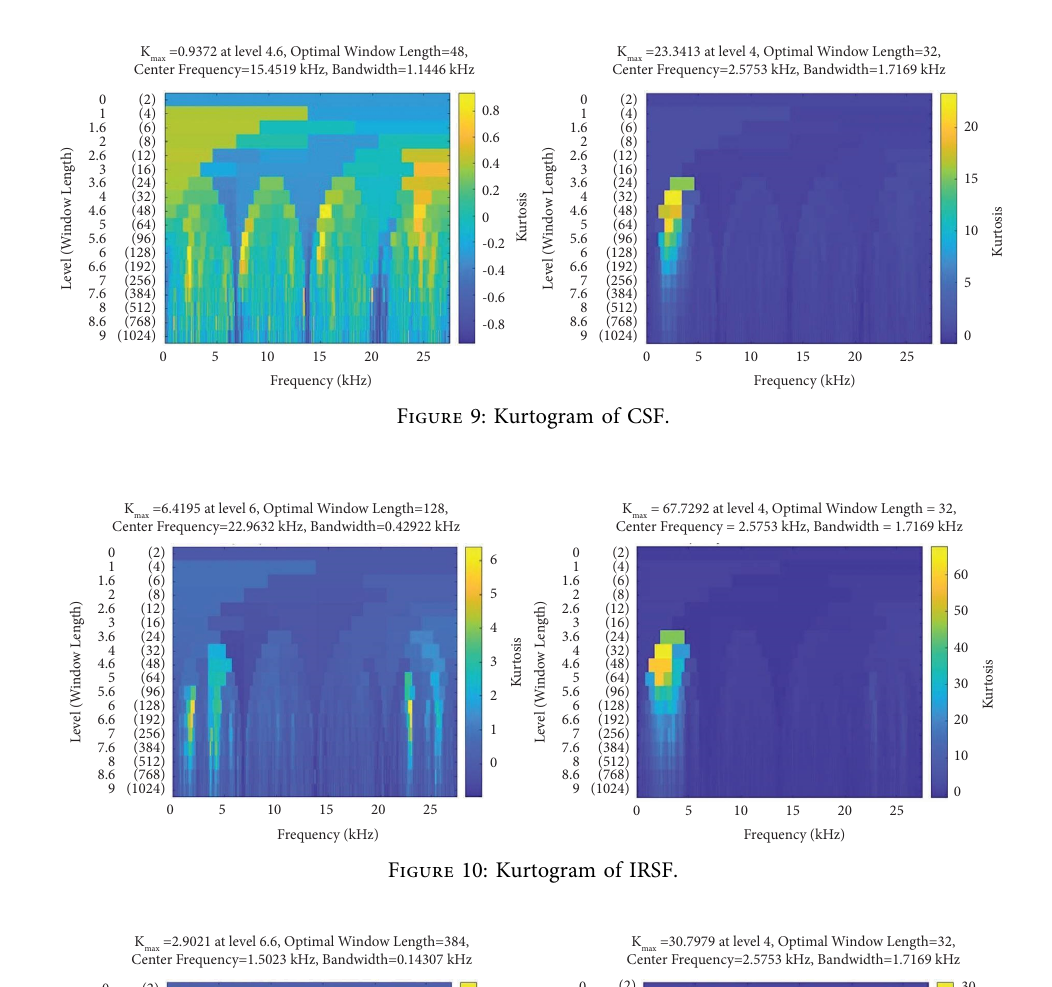
Figure 8: Kurtogram of CMF.